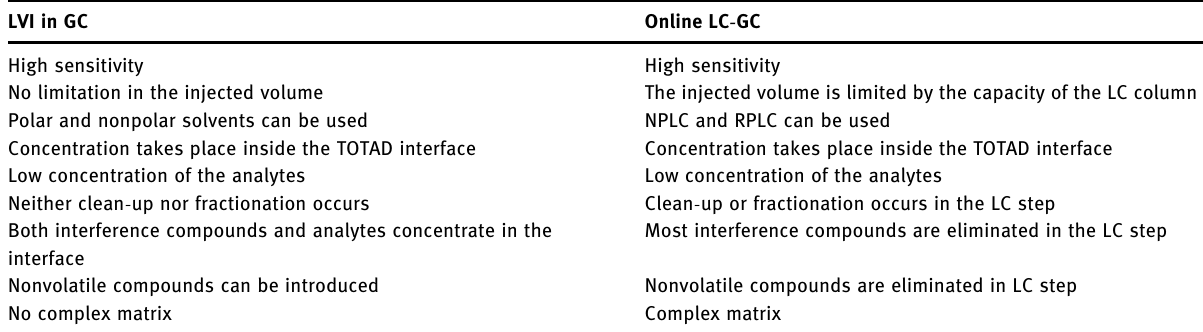
Table 1: Comparison of LVI and online LC - GC using the TOTAD interface LVI in GC